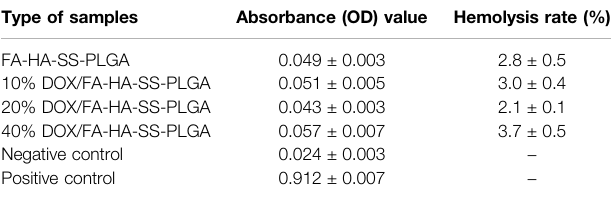
TABLE 2 | Hemolysis rate of different micelles ( n = 3, (cid:1) x ± SEM). Type of